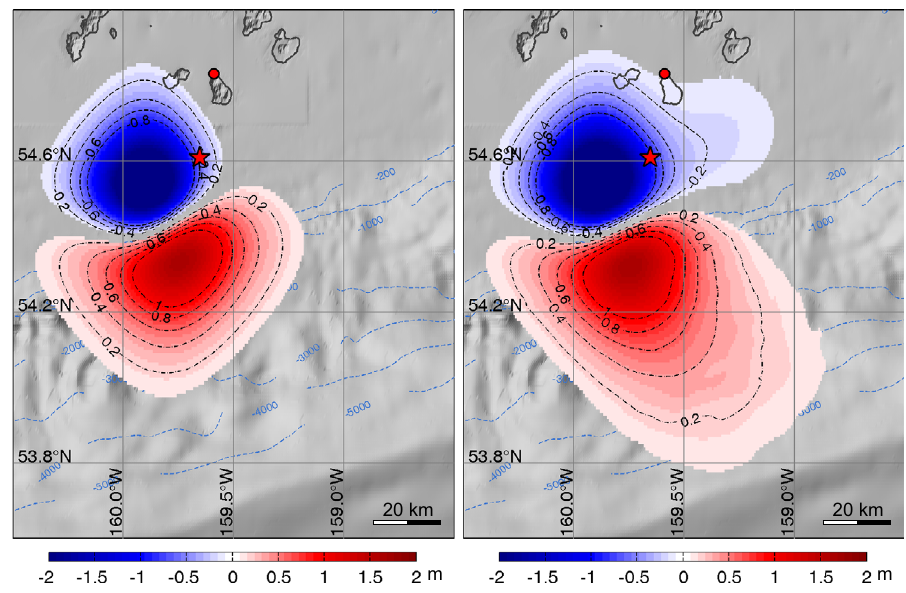
Fig. 5 | Sea fl oor deformation for the dipole models. Sea fl oor deformation for an optimized dipole model alone (left) and combined with the two-fault fast-slip model in Fig. 3 (right). Tsunami waveform predictions for this model are shown in